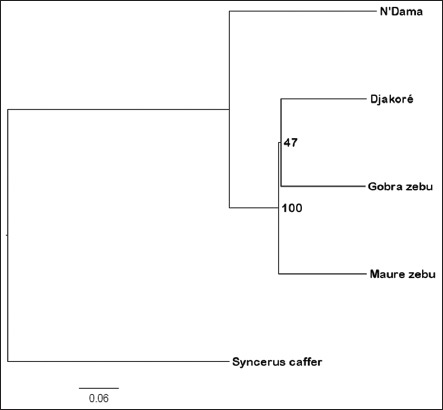
Neighbor-Joining tree showing genetic relationships among four Senegalese cattle breeds using DC genetic distances [32]. The numbers on the nodes are percentage bootstrap values for 10,000 replications. The linear scale relates the branch lengths to units of DC. The root of the tree was placed at the midpoint of the longest branch separating the Syncerus caffer from the other groups.